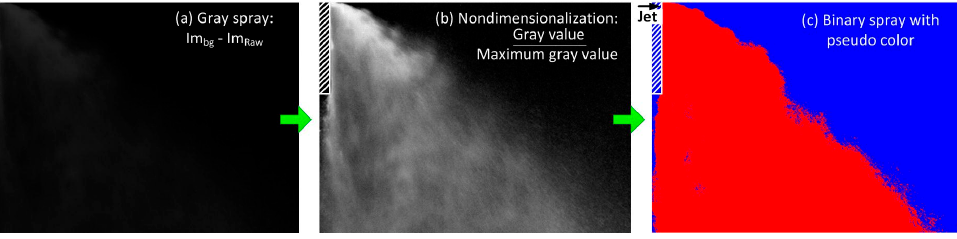
Figure 5. Preprocessing of the frozen spray pattern.